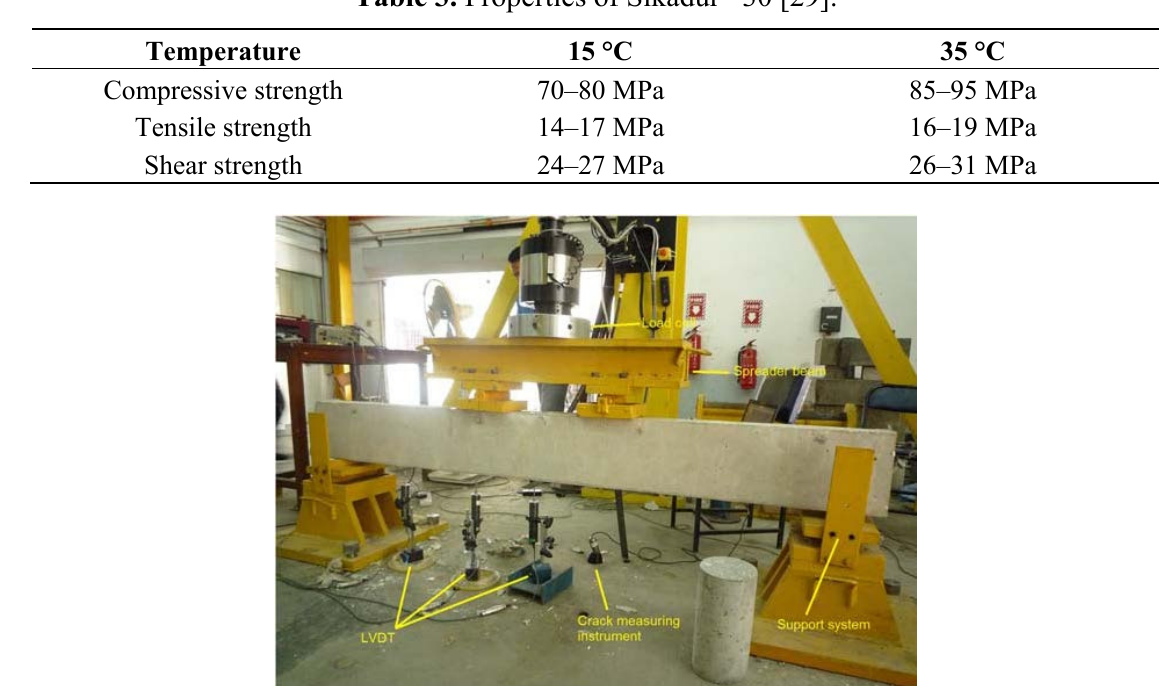
Table 3. Properties of Sikadur ® 30 [29].